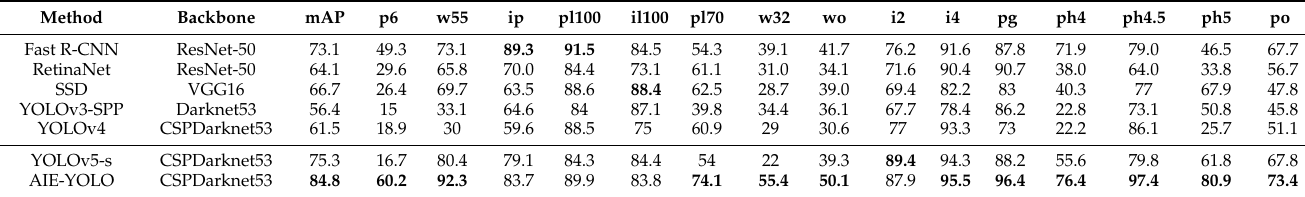
Table 2. AP (part of traffic sign categories) and mAP comparison of different networks on the TT100K testing